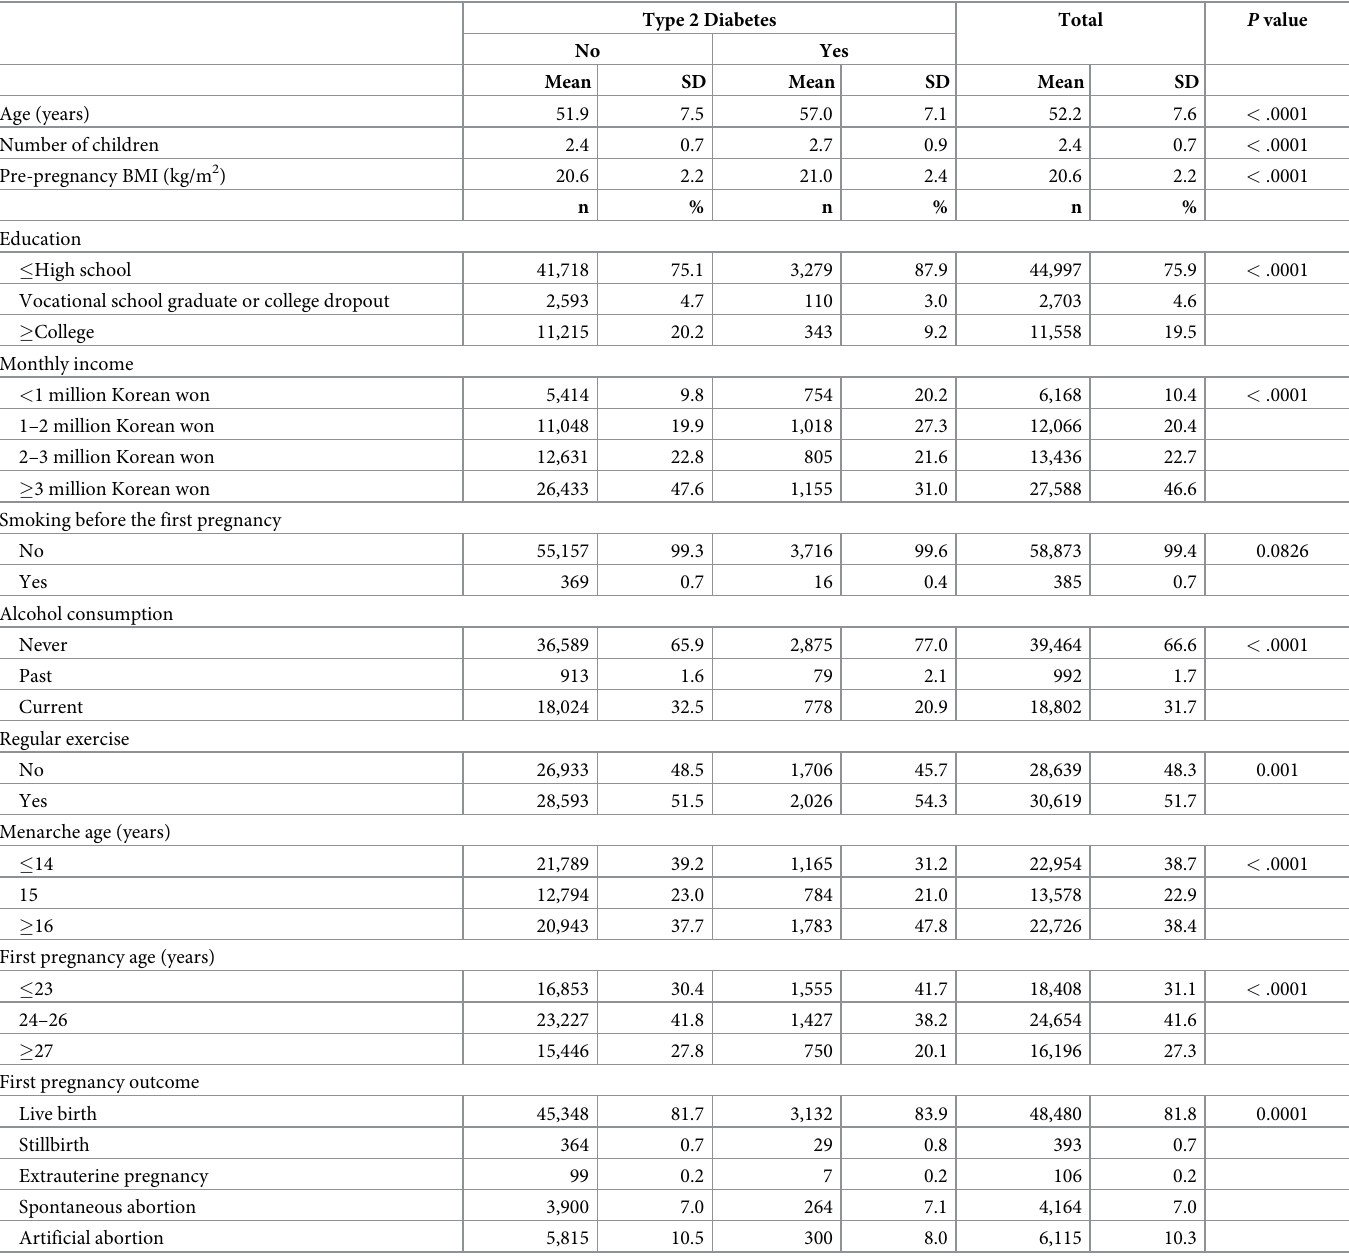
Table 1. Distributions of sociodemographic, lifestyle, and reproductive characteristics of the study population in the Health Examinee Study (HEXA)